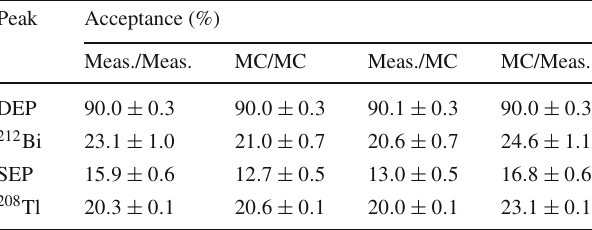
Table 5 Event survival fractions for different training/classification options for the simulated and measured 228 Th data. (Meas./Meas.), (MC/MC), (Meas./MC) and (MC/Meas.) denote the scenarios when: ANN was trained and applied to the measured data, ANN was trained and applied to the simulated data, ANN was trained on the measured data and applied to the simulated one and vice versa, respectively. The first two options were discussed earlier and were included for compar- ison purposes